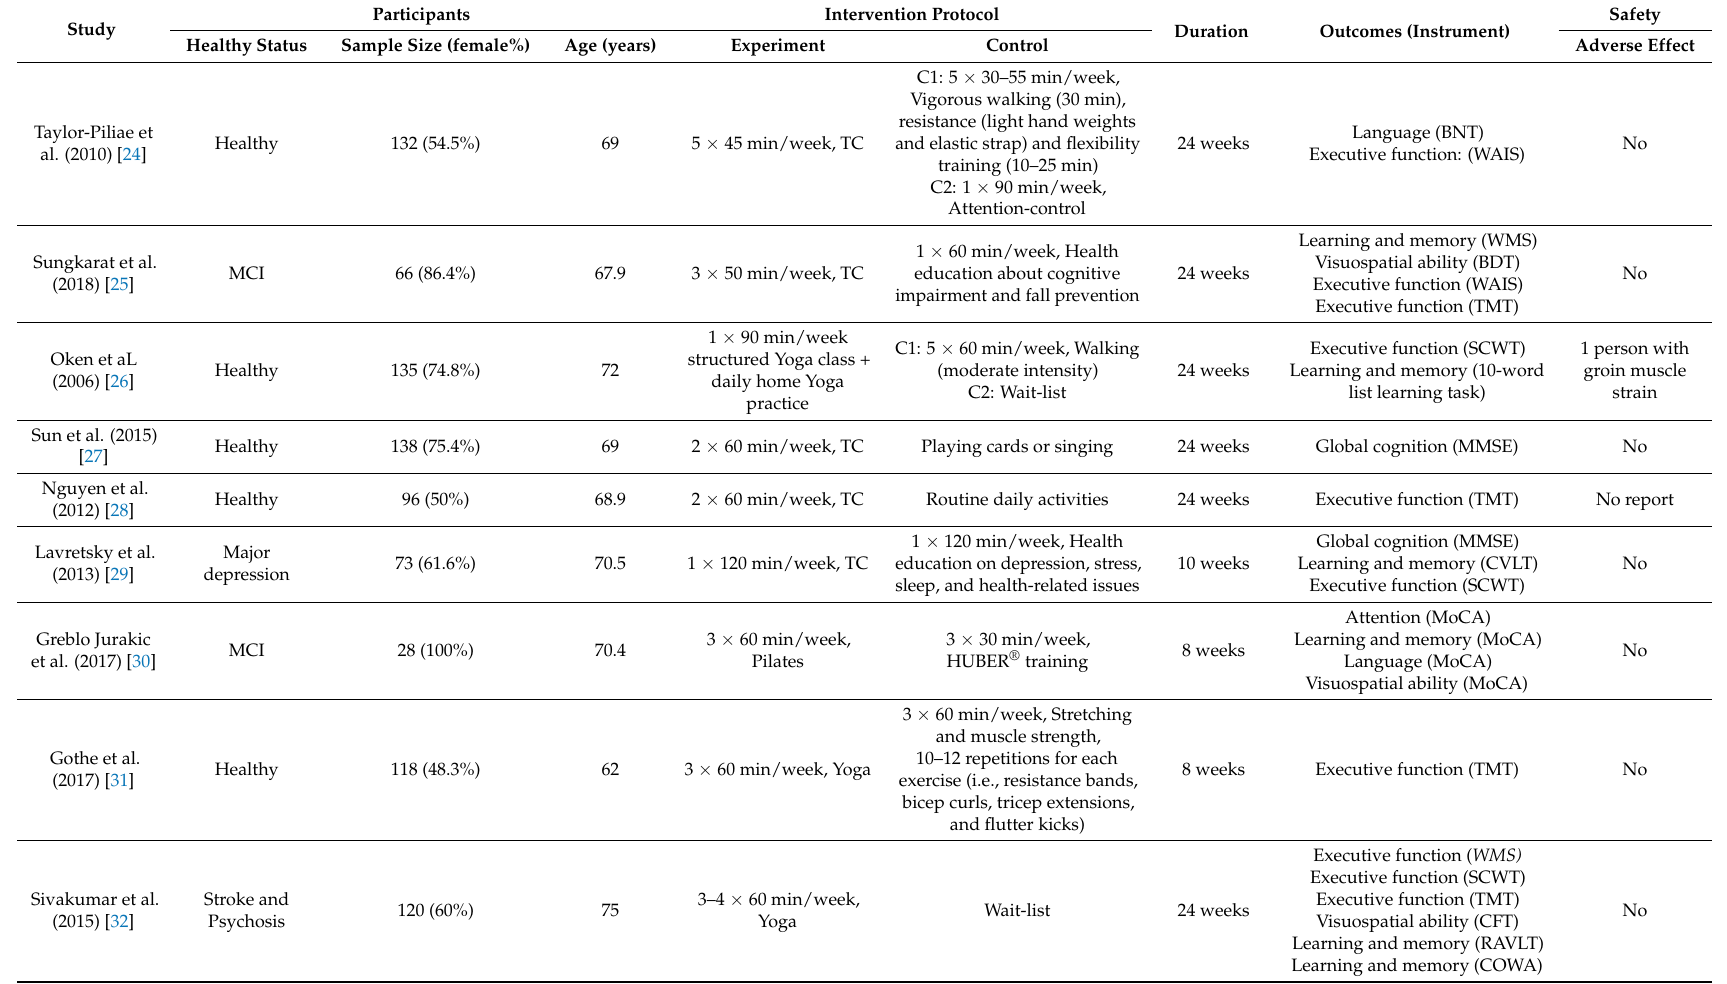
Table 1. Characteristics of randomized controlled trials in the